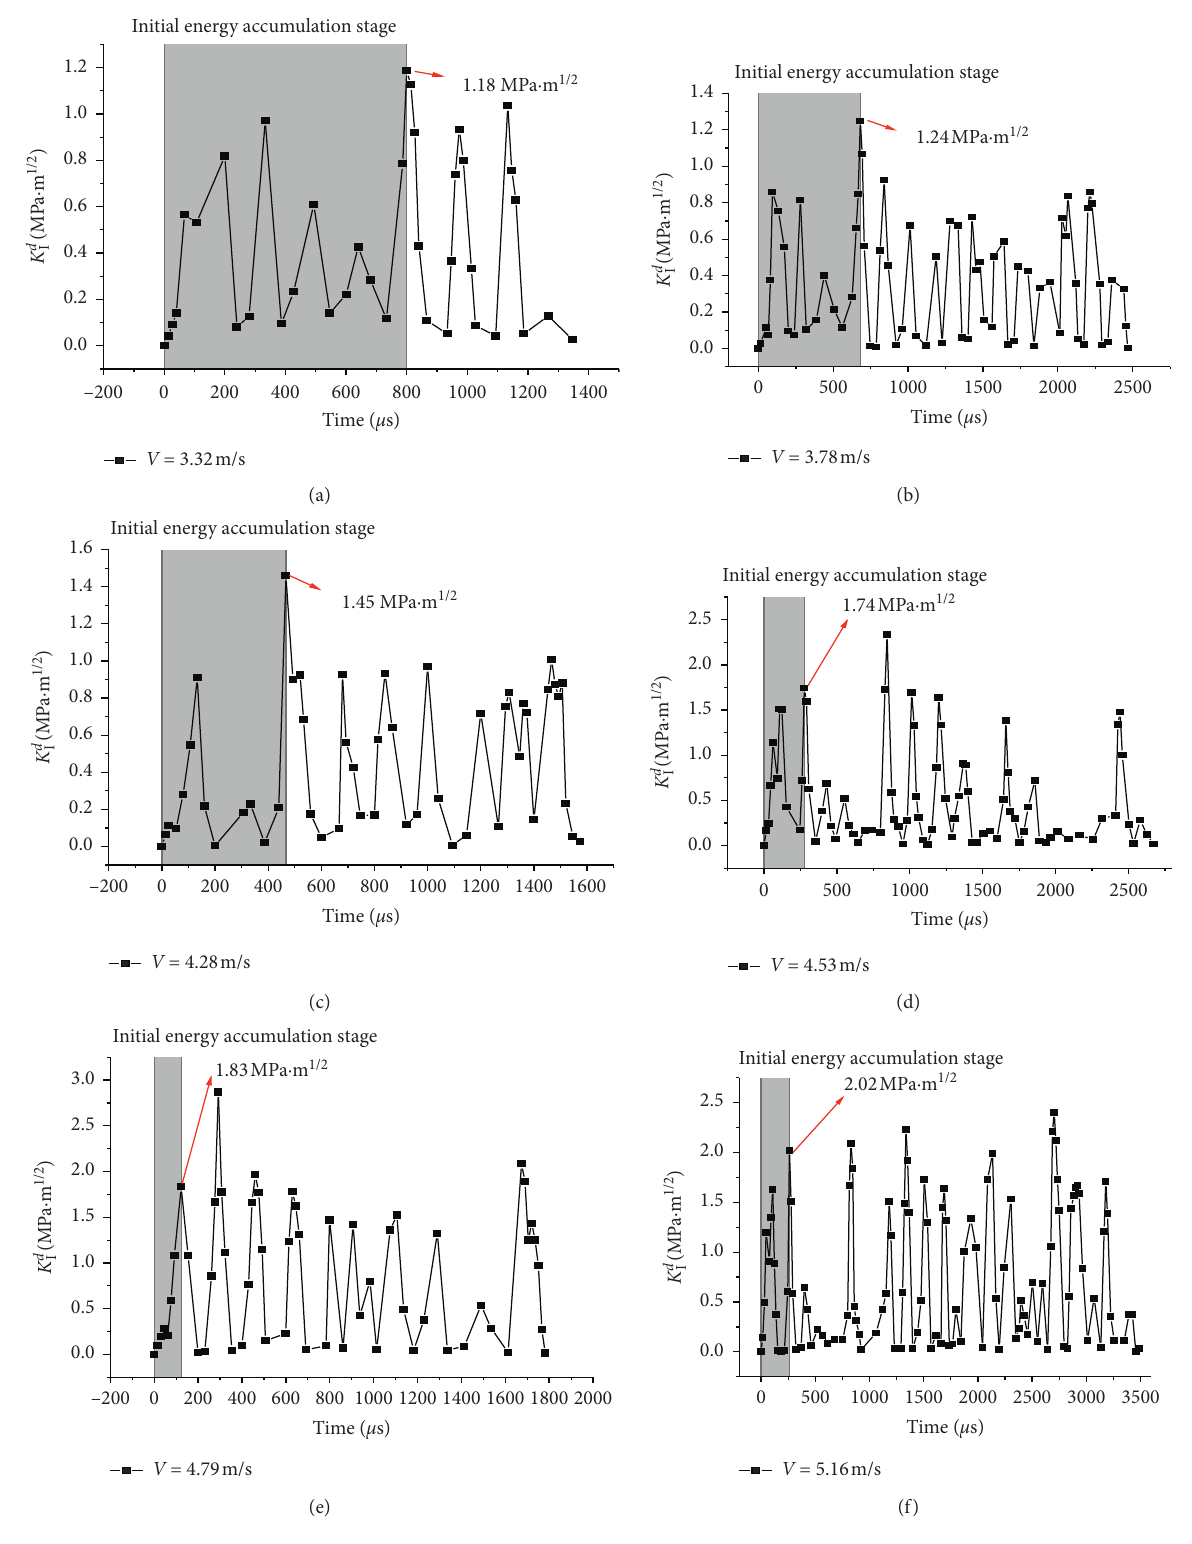
Figure 9: DSIF versus time results for different impact velocities. (a) V � 3.32m/s. (b) V � 3.78m/s. (c) V � 4.28m/s. (d) V � 4.53m/s. (e) V � 4.79m/s. (f) V �